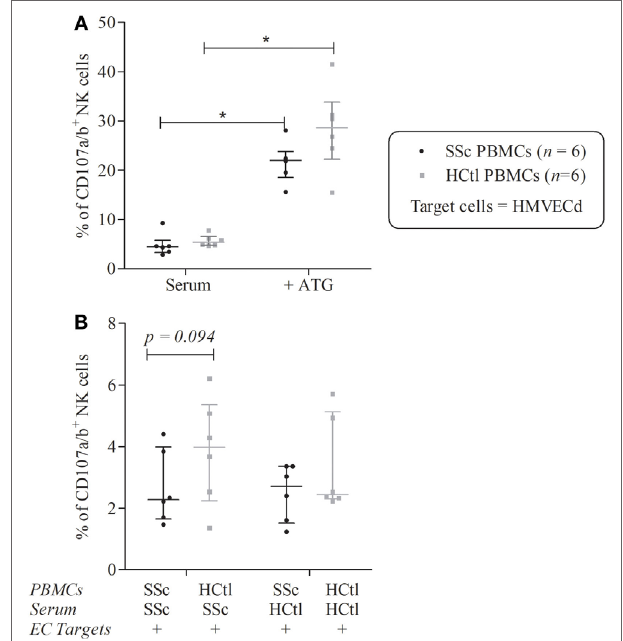
FigUre 6 | Natural killer (NK) cells degranulation of systemic sclerosis (SSc) patients toward microvascular endothelial cell (EC) target. Cytolytic degranulation of NK cells was assessed by flow cytometry analysis of CD107a/b expression of NK cells among peripheral blood mononuclear cells (PBMCs) after a 4-h coculture with human microvascular dermal ECs (HMVEC-d) with an effector/target ratio of 2/1. (a) PBMCs from patients with SSc ( n = 6) and healthy controls (HCtl) ( n = 6) were cultured with HMVEC-d with or without thymoglobulin (ATG). (b) PBMCs from SSc patients ( n = 6) and HCtl ( n = 6) were cultured with HMVEC-d and either SSc serum or HCtl serum and conversely. Cumulative data from five independent experiments. Results were expressed as median percentages ± interquartile range. Statistical significance was established using the non-parametric paired Wilcoxon U -test. * p <